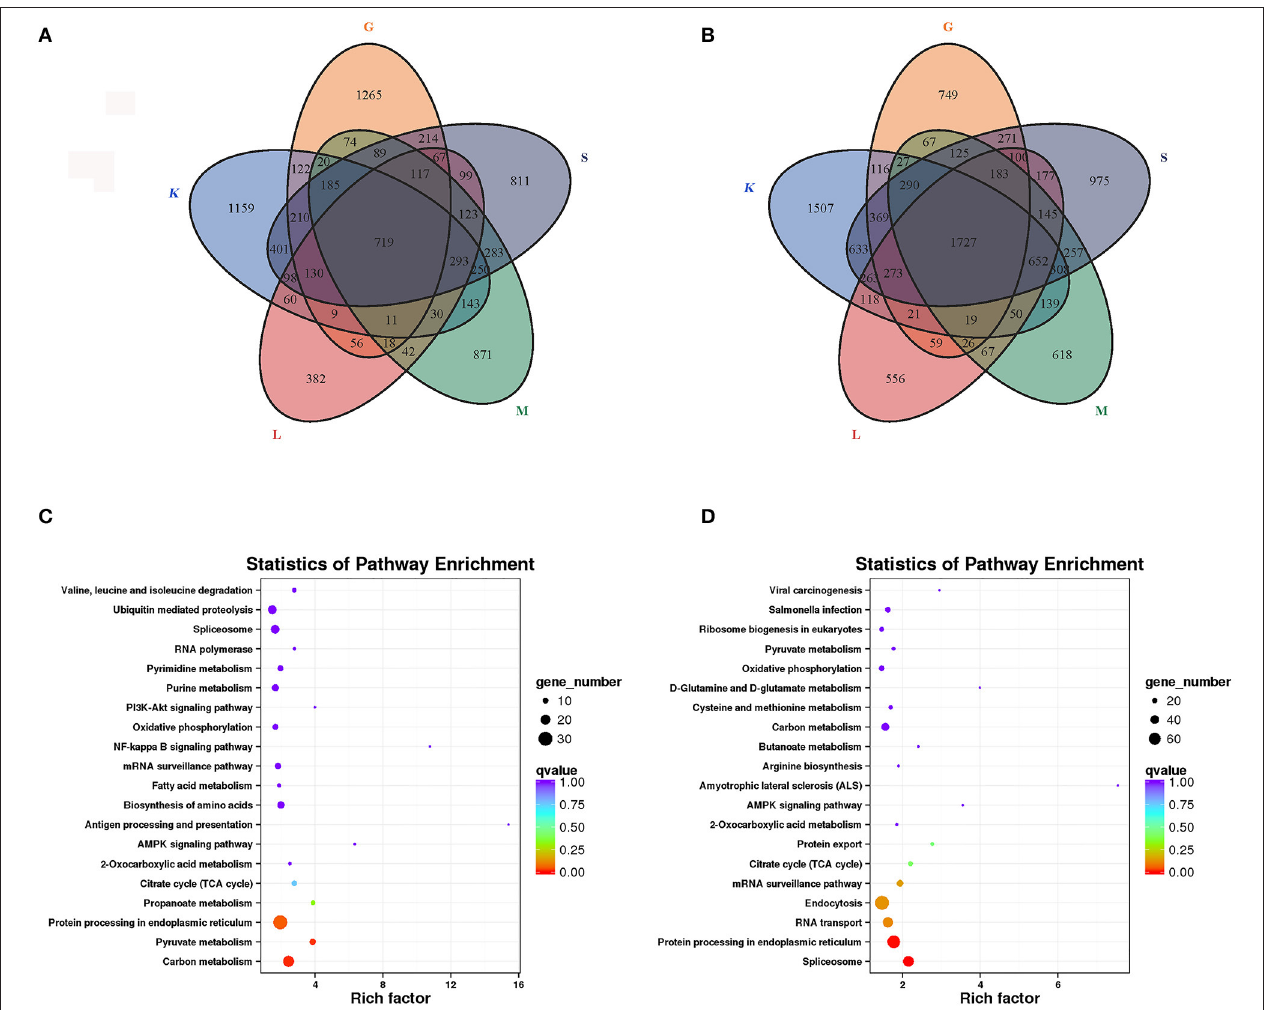
FIGURE 3 | Expression analysis of DEGs in five tissues of lenok. (A) Upregulated DEGs; (B) Downregulated DEGs; K, head kidney; L, liver; M, muscle; S, spleen; G, gonad; (C) KEGG analysis of upregulated DEGs; (D) KEGG analysis of downregulated DEGs.